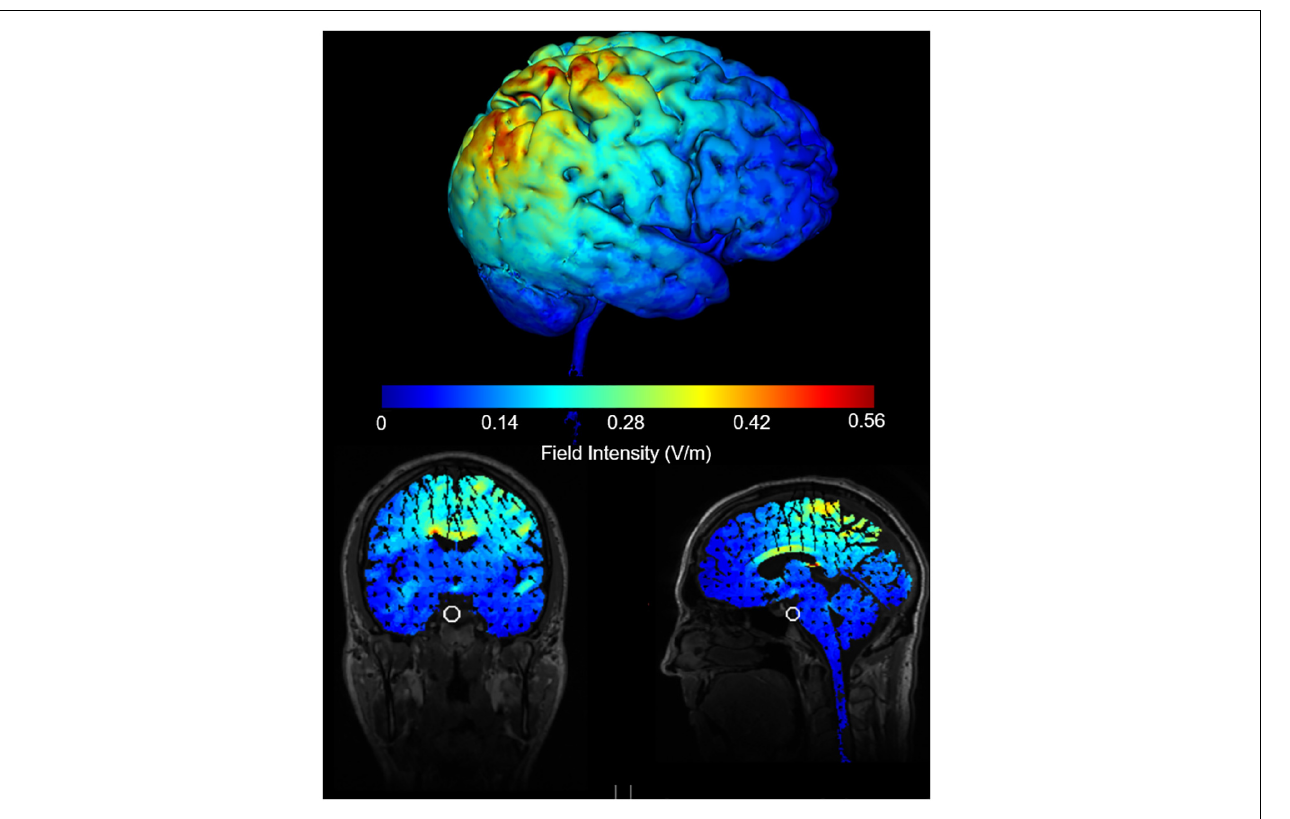
FIGURE 2 | Induced e-field modelling of tACS parameters when electrodes are positioned at Cz and P4 and delivering 2 mA peak to peak intensity.